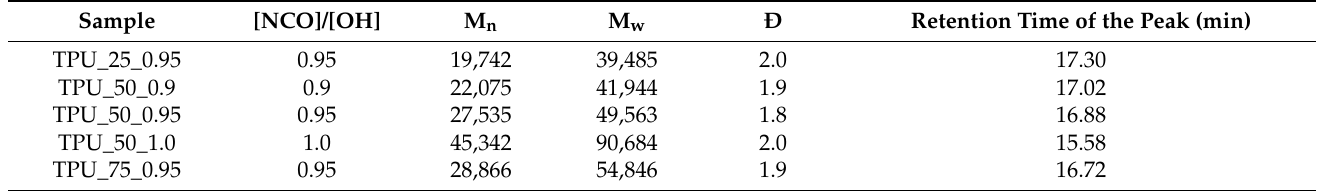
Figure 3. The GPC chromatograph of the prepared green TPUs. Table 1. The results of the GPC measurements.